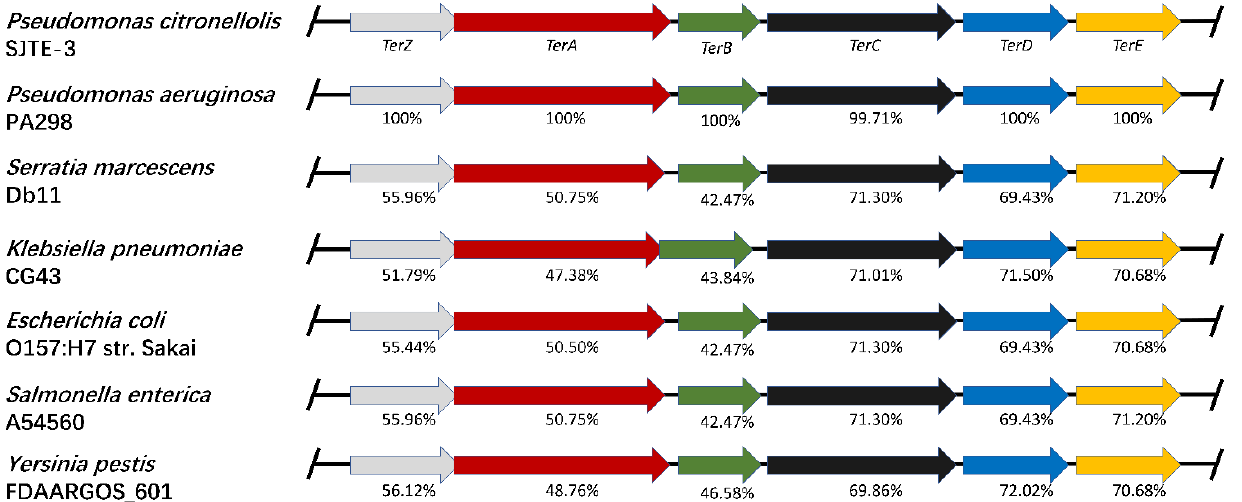
Figure 3. Comparison of the tellurite-resistance gene clusters in different bacteria. The terZABCED gene clusters in the plasmids from P. citronellolis SJTE-3, P. aeruginosa PA298, Serratia marcescens CG43, E. coli O157, S. enterica A54560, and Y. pestis FDAARGOS_601 were aligned with Mauve. The terZABCDE genes were labeled in gray, red, green, black, blue, and yellow, respectively. The percentage represented the similarity of tellurite-resistance proteins from other bacteria to those from strain SJTE-3.